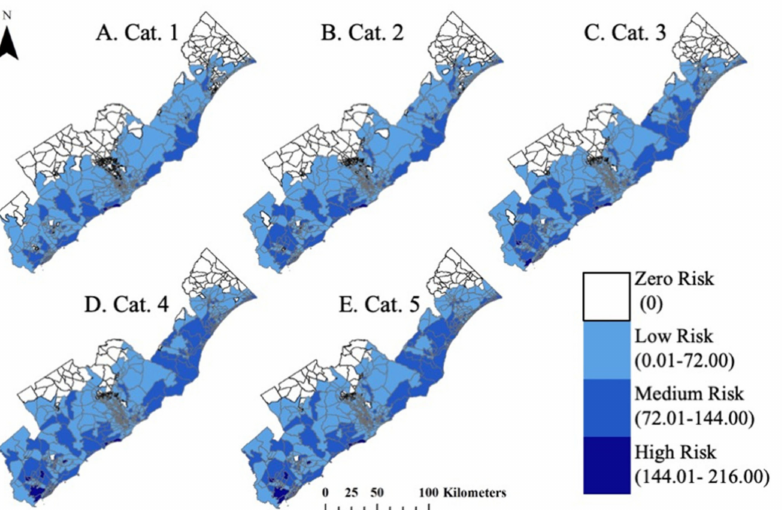
Figure 6. ( A – E ) Images A through E illustrate the spatial Relative Risk Model results of hurricane- induced storm-surge flood risk for the more vulnerable younger (<5 years) and older (>60 years) populations of the eight coastal South Carolina counties, mapped by US Census block group